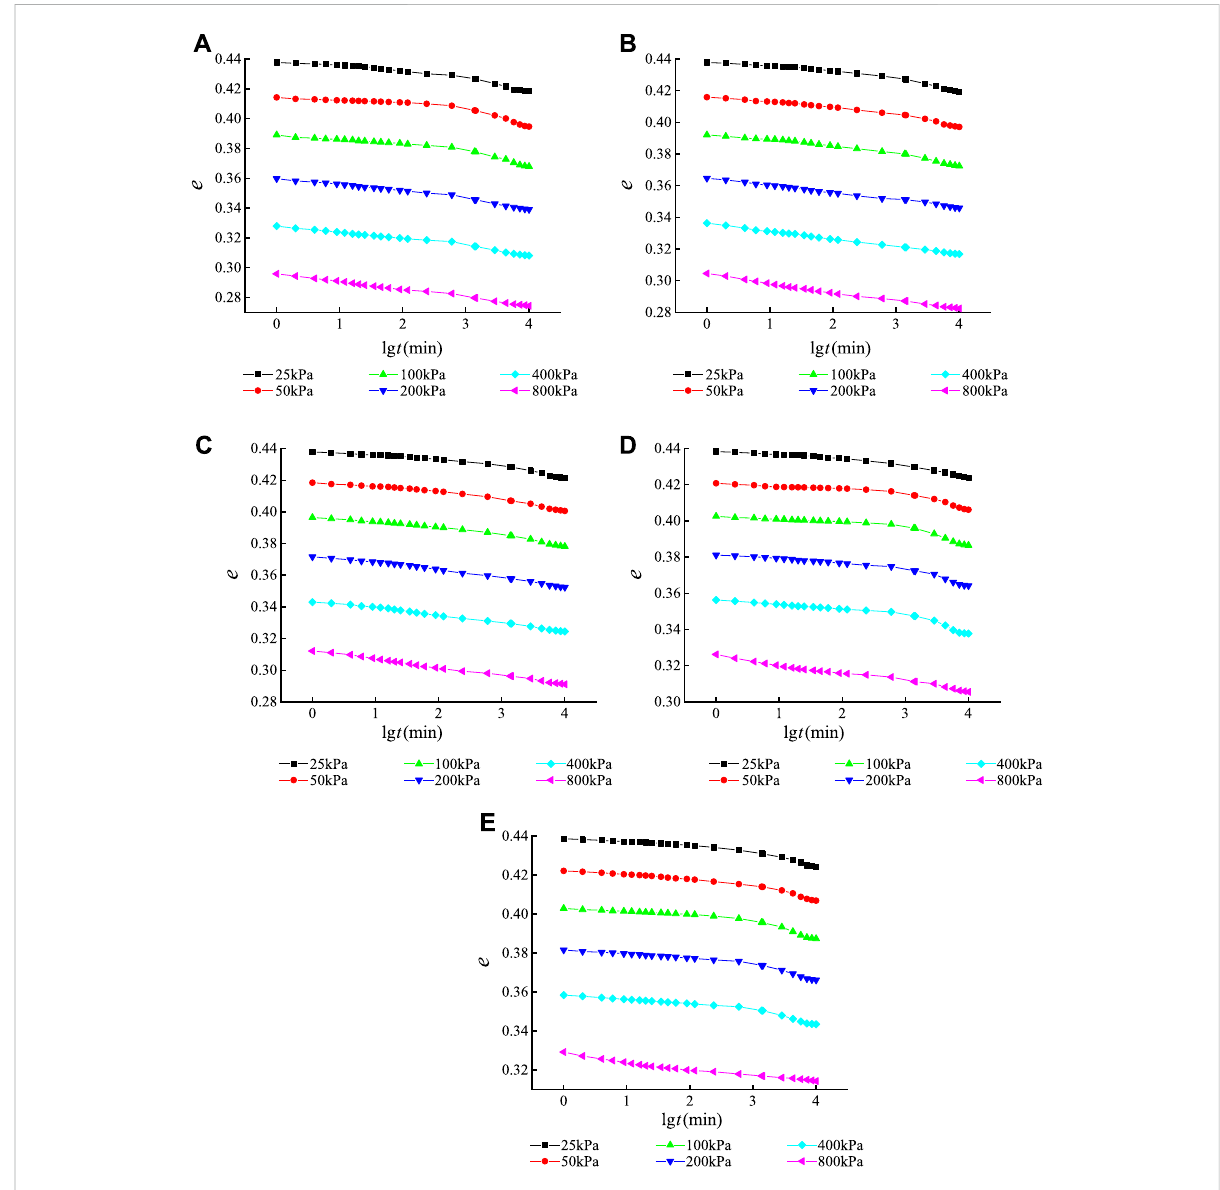
FIGURE 4 e -lg t relation curves: (A) bio-enzyme ratio of 0.00%, (B) bio-enzyme ratio of 0.01%, (C) bio-enzyme ratio of 0.02%, (D) bio-enzyme ratio of 0.03%, and (E) bio-enzyme ratio of 0.04%.